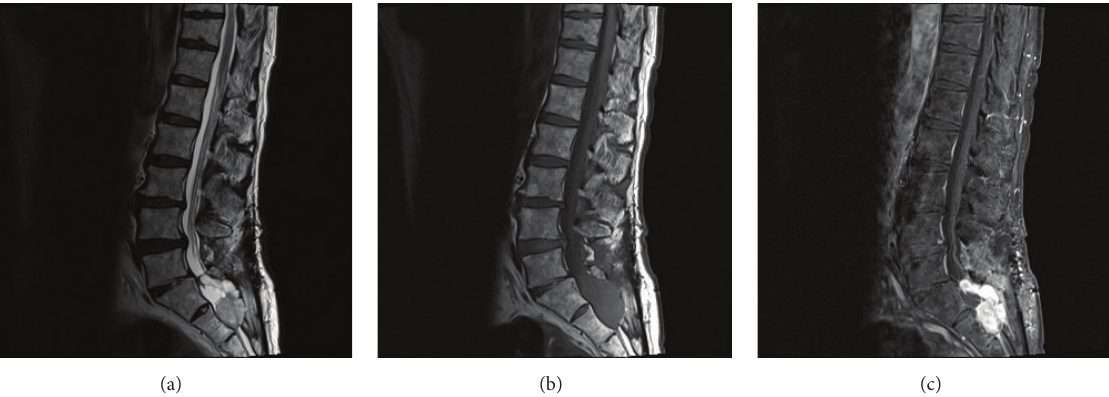
Figure 3: MRI of the lumbar spine with and without contrast. (a) Sagittal T2, (b) sagittal T1, and (c) sagittal T1 after fat saturation: significant enlargement of previously noted sacral mass with new bony erosion and significant mass effect within the spinal canal causing displacement of posterior spinal structures. The mass has taken a more lobulated appearance as seen on the T2 images and is vividly contrast